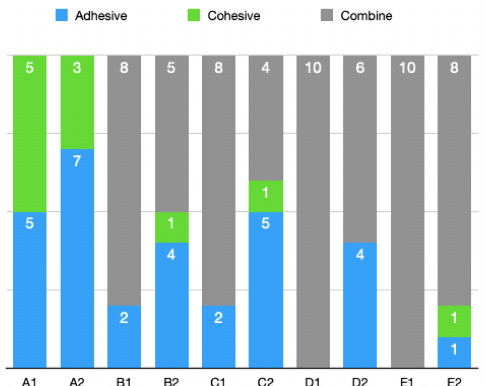
Figure 5. Fracture types (adhesive/cohesive/combine) comparison in all groups.